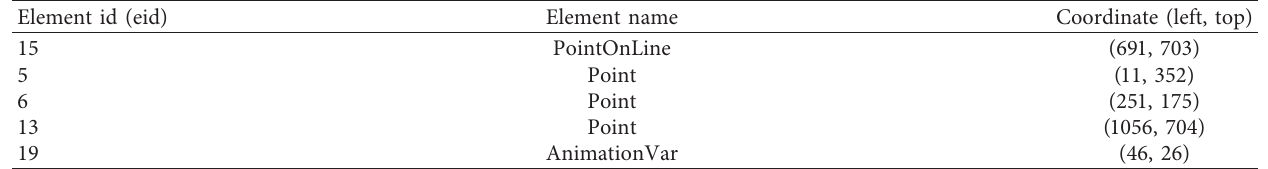
Table 4: Coordinate information of interactive elements in “translation of polygon.”